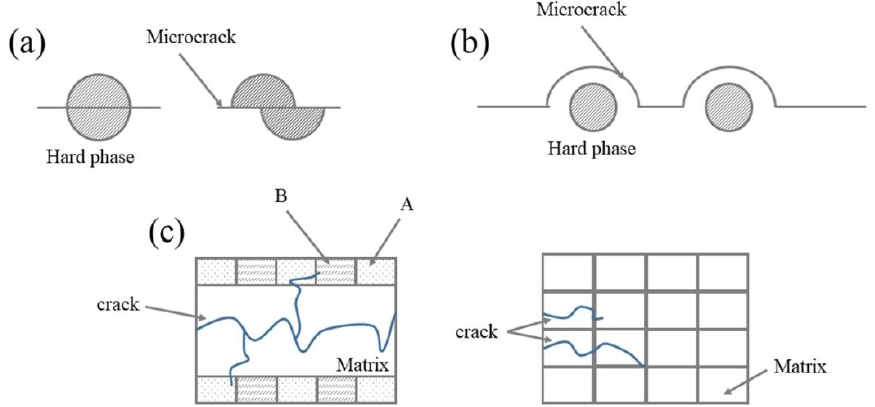
Figure 13. Schematic diagram of the hindrance of hard phase and biomimetic structure with respect to crack propagation: ( a ) Microcrack shear through the hard phase; ( b ) Microcracks bypass the hard phase; ( c ) The biomimetic reticulation structure hinders the propagation of cracks in the longitudinal and transverse directions.